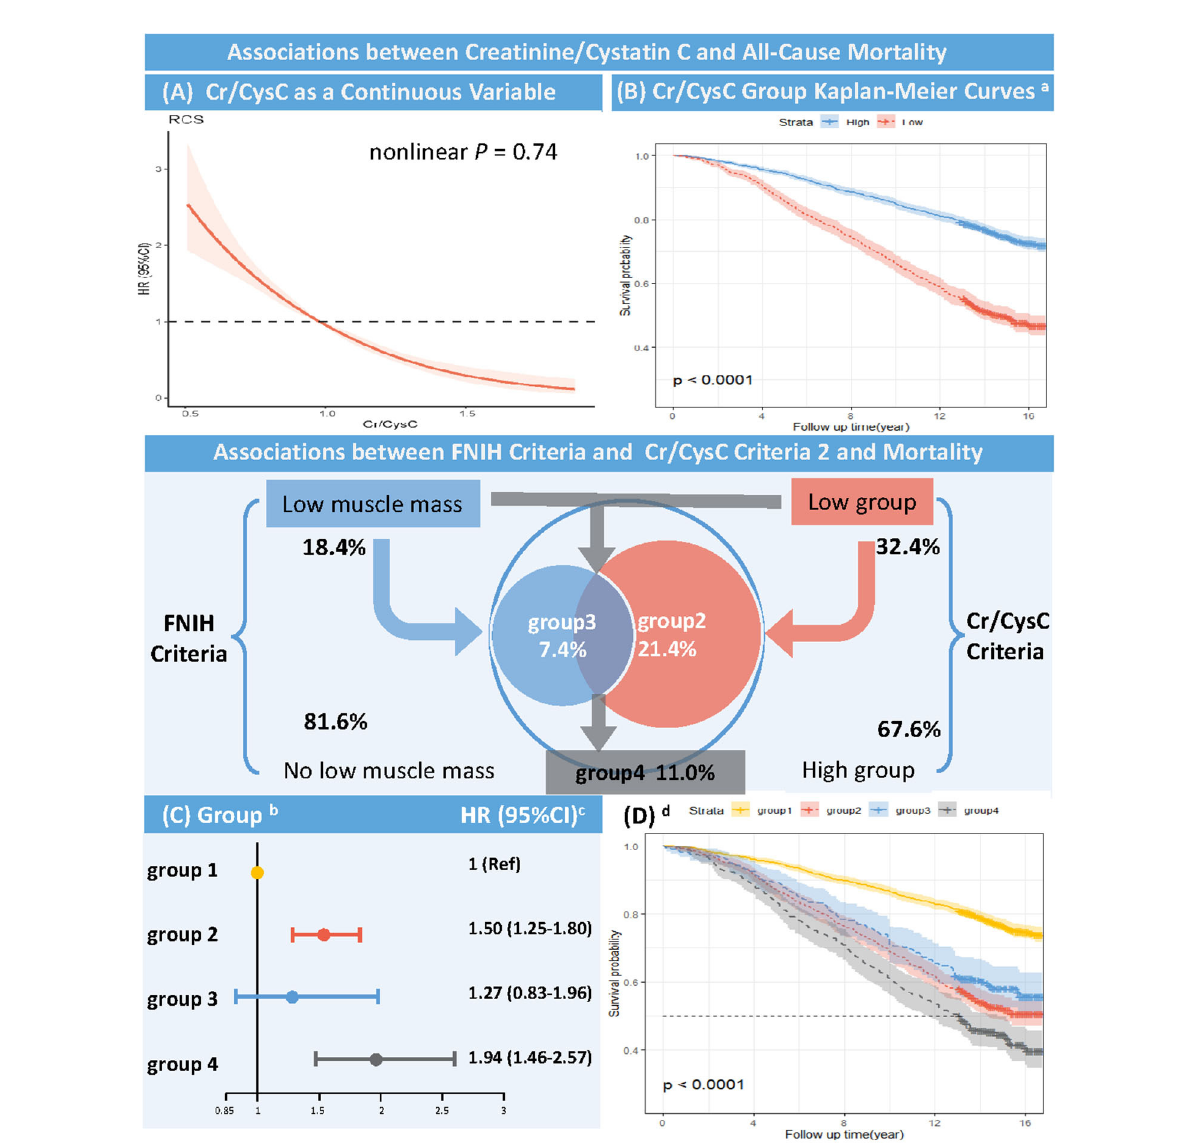
FIGURE2 Association between Creatinine/Cystatin C and All-cause Mortality (Unweighted) RCS, restricted cubic spline; Cr, creatinine; CysC, Cystatin C; FNIH, Foundation of the National Institute of Health. (A) RCS of HR and 95% CI for the association between Cr/CysC (continuous) and all-cause mortality (Nonlinear P = 0.74). (B) Kaplan-Meier curves according to Cr/CysC criteria (unweighted). a The cut-off values were defined by the sex-specific 20th percentile of Cr/CysC in participants aged 18–44 years (Cr/CysC: Male < 1.0, Female < 0.8). High group: Cr/CysC criteria 2 define no low muscle mass; Low group: Cr/CysC criteria 2 define low muscle mass (Log-rank test, P < 0.001). (C) Multivariate Cox proportional risk model (weighted). b Group 1 = both Cr/CysC and FNIH criteria define no low muscle mass; Group 2 = only Cr/CysC criteria define low muscle mass; Group 3 = only FNIH criteria define low muscle mass; Group 4 = both Cr/CysC and FNIH criteria define low muscle mass. The cut-off values were defined by the sex-specific 20th percentile of Cr/CysC in participants aged 18–44 years (Cr/CysC: Male < 1.0, Female < 0.8). c Adjusted age, sex, race/ethnicity, total fat mass, blood urea nitrogen, total cholesterol, hemoglobin A1c, albumin, and hemoglobin. (D) Kaplan-Meier curves according to Cr/CysC and FNIH criteria. d Group 1 = both Cr/CysC and FNIH criteria define no low muscle mass; Group 2 = only Cr/CysC criteria define low muscle mass; Group 3 = only FNIH criteria define low muscle mass; Group 4 = both Cr/CysC and FNIH criteria define low muscle mass. The cut-off values were defined by the sex-specific 20th percentile of Cr/CysC in participants aged 18–44 years (Cr/CysC: Male < 1.0, Female < 0.8) (Log-rank test, P < 0.001).